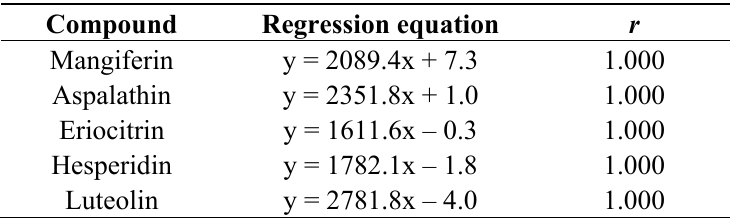
Table 3. Linear regression data for calibration curves.